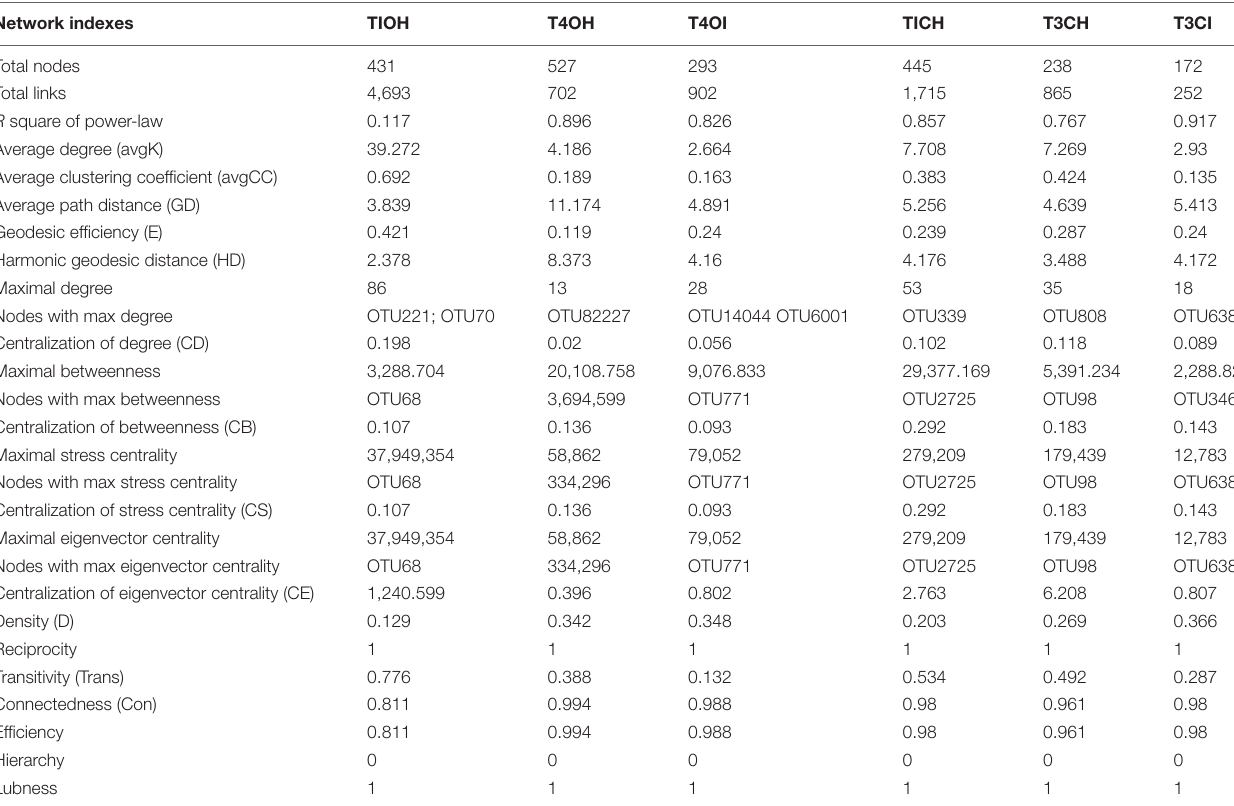
TABLE 2 | Topological indices of microbial co-occurrence network in different treatments. Network indexes